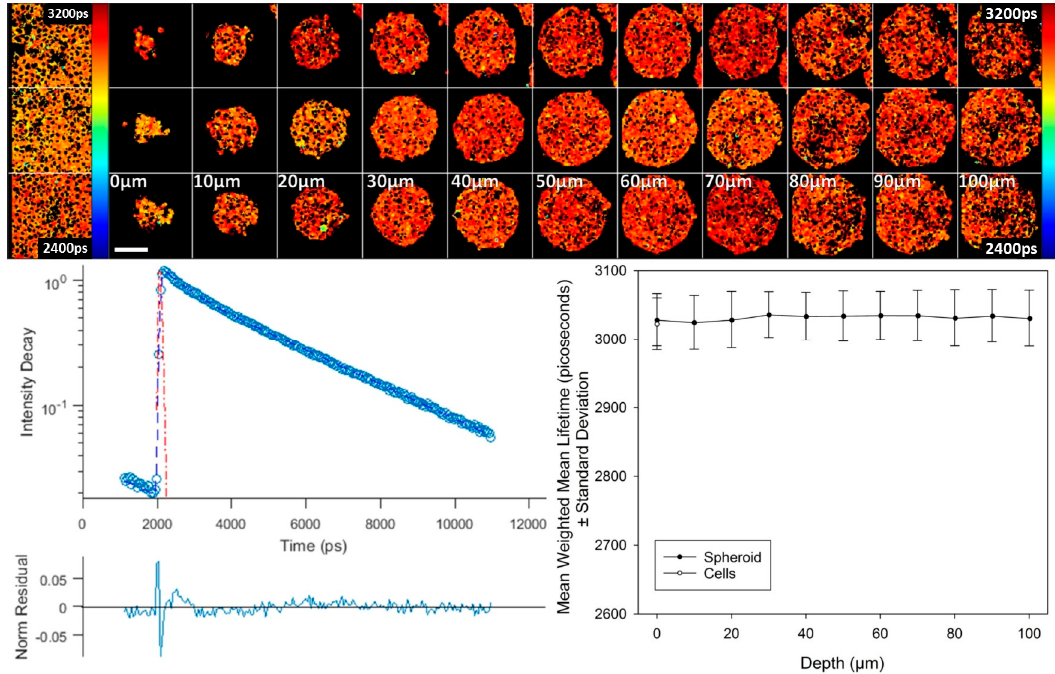
Figure 5. TPE-TCSPC FLIM in spheroids expressing T2AMPKAR-T391A-NES. Top left panel: the weighted mean fluorescence lifetime map for 2D cultures. Top right panel : the weighted mean fluorescence lifetime map for three spheroids at different depths (shown in panel); Left lower panel : exemplar fluorescence decay profile plotted (blue circles) with double exponential fitting (blue line), IRF (red dashed line), and residuals (lower); Lower right panel : plot of the mean weighted mean fluorescence lifetime versus depth. Lifetimes are shown in picoseconds (shown in image). Scale bar = 100 µm.